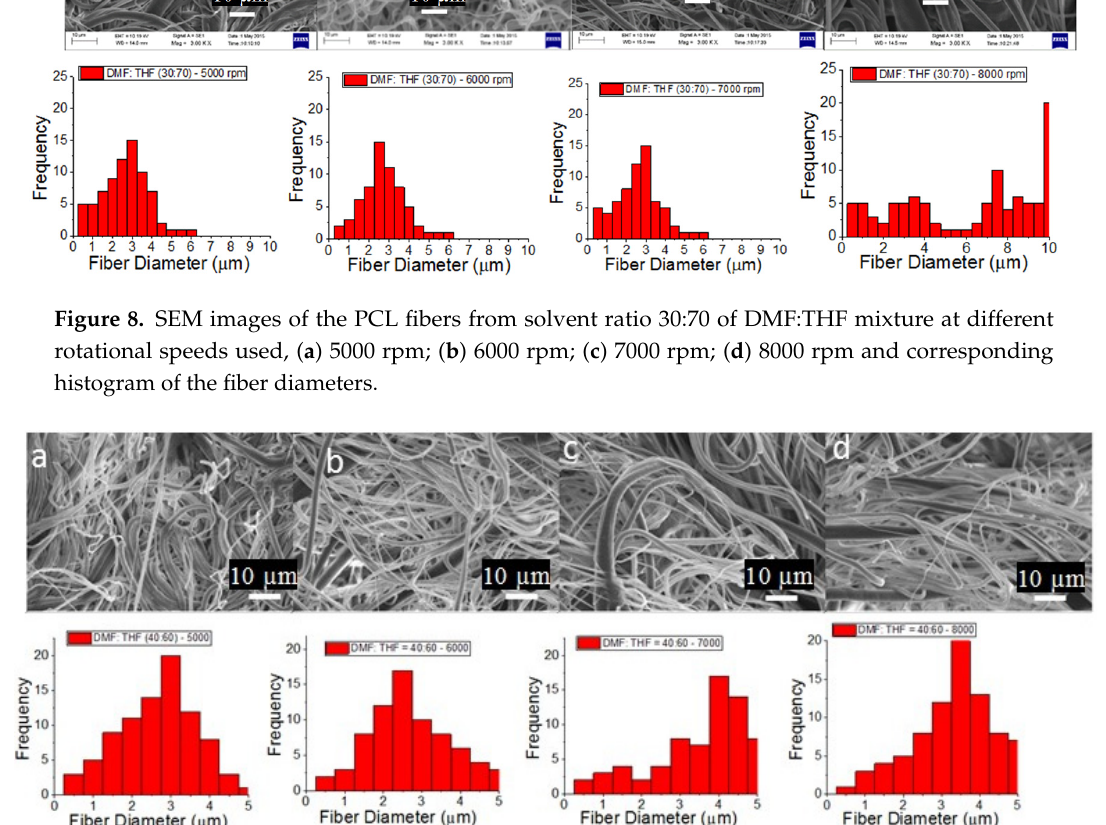
Figure 9. SEM images of the -prepared samples of the PCL fibers with solvent ratios of DMF:THF at 40:60 and at different rotational speeds used, ( a ) 5000 rpm; ( b ) 6000 rpm; ( c ) 7000 rpm; ( d ) 8000 rpm and corresponding histogram of the fiber diameter.